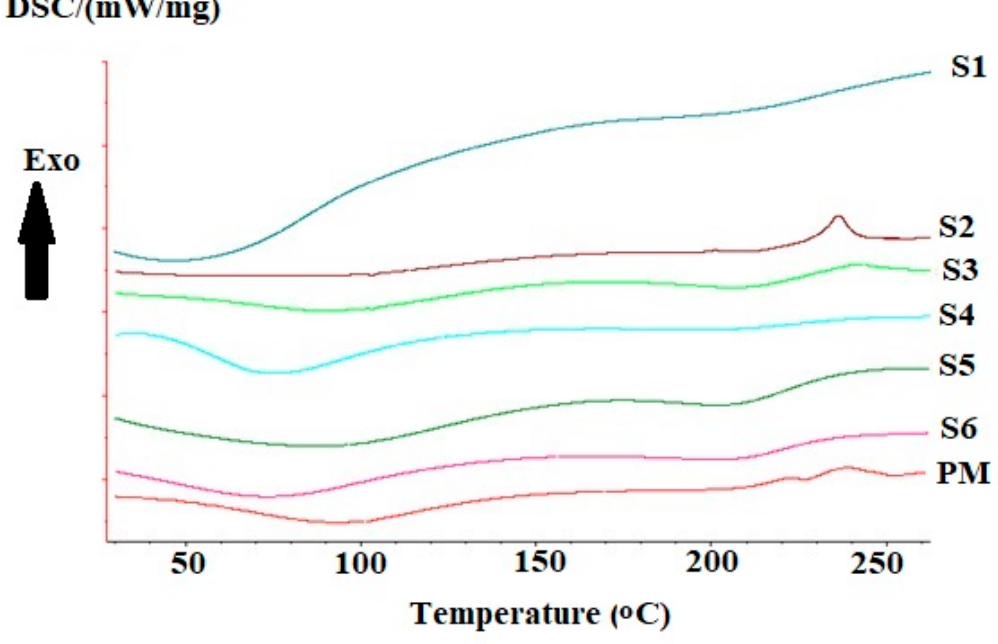
Figure 3. Di ff erential scanning calorimetry thermograms of prepared samples 1, 2, 3, 4, 5, 6, and the corresponding physical mixture.